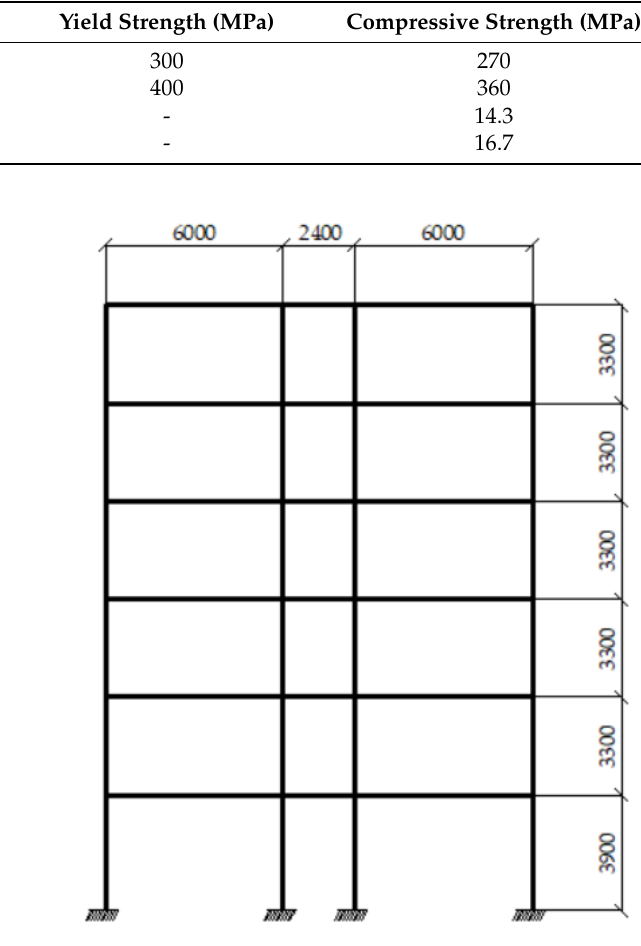
Table 3. The mechanical properties of reinforcements and concrete.